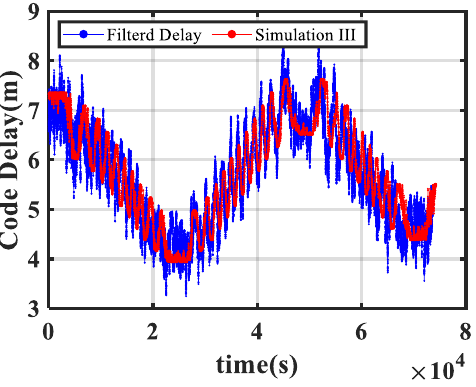
Figure 9. The comparison between the filtered delay measurements (blue) and simulation III (red).